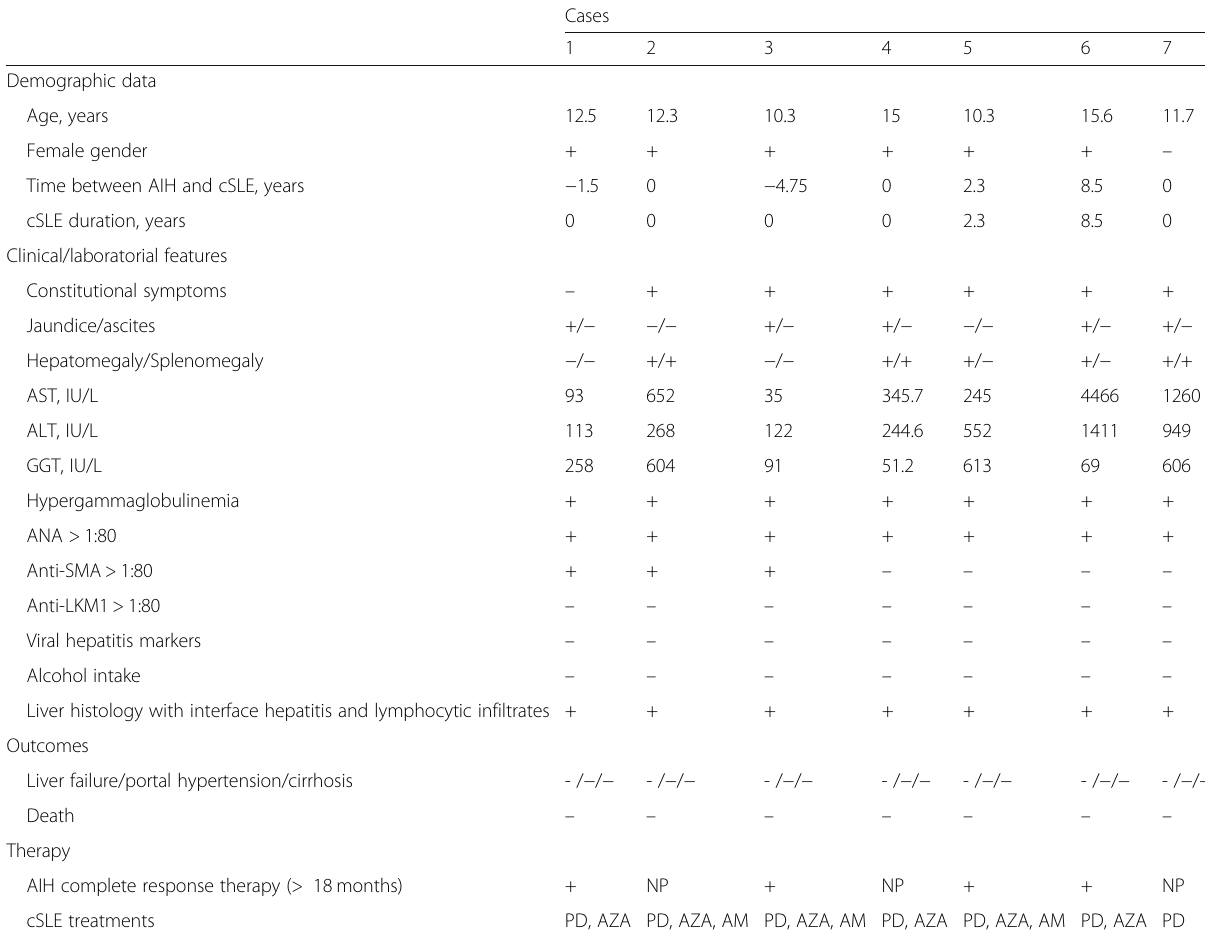
Table 1 Demographic data, clinical and laboratorial features, outcomes and treatments in childhood-onset systemic lupus erythematosus (cSLE) patients with autoimmune hepatitis